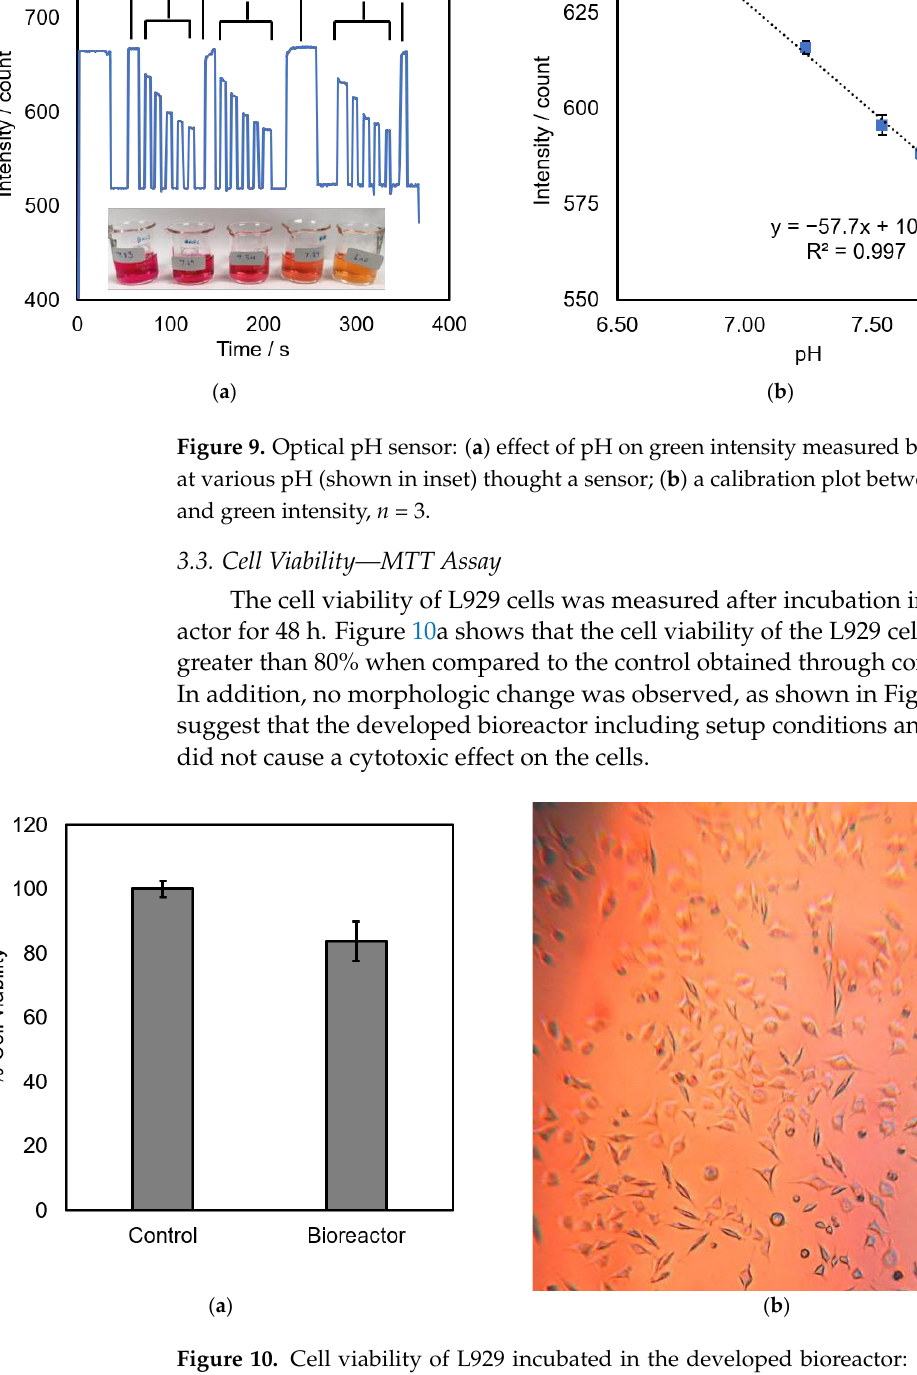
Figure 11. Cell proliferation of L929 incubated in the developed bioreactor. The number of cells was counted at 24 and 72 h after incubation and the data were analyzed by two-way ANOVA and post- hoc using R program. * Statistical significance was set at p < 0.05, n = 3.